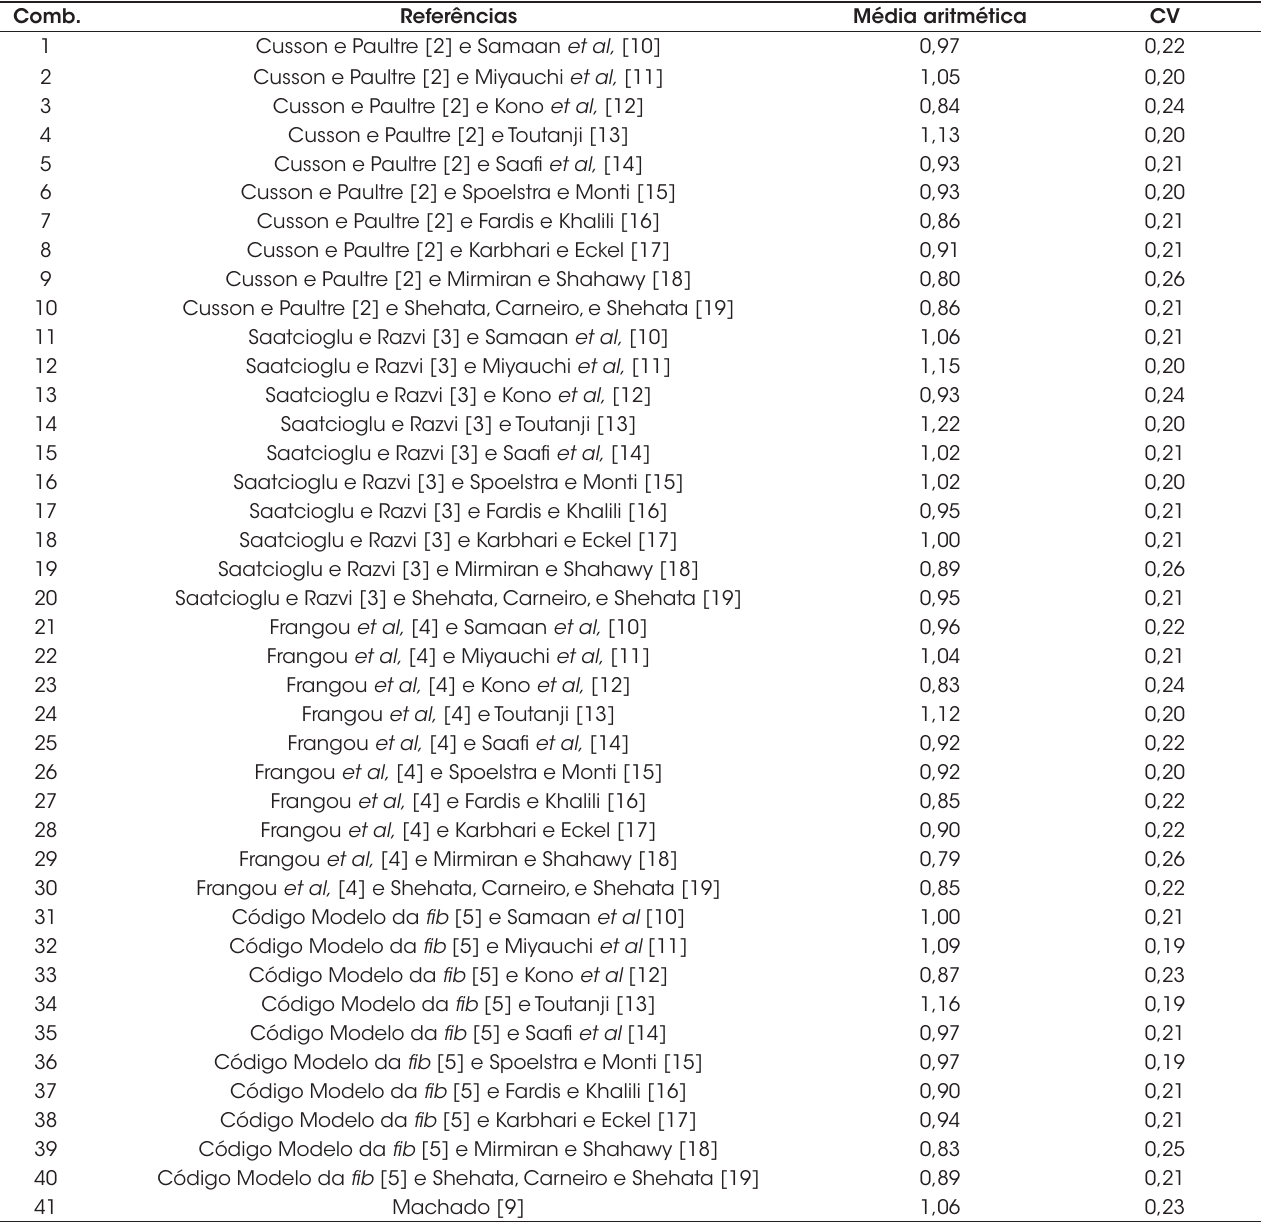
Comparativo entre os resultados teóricos e experimentais dos pilares confinados com PRF e armadura transversal